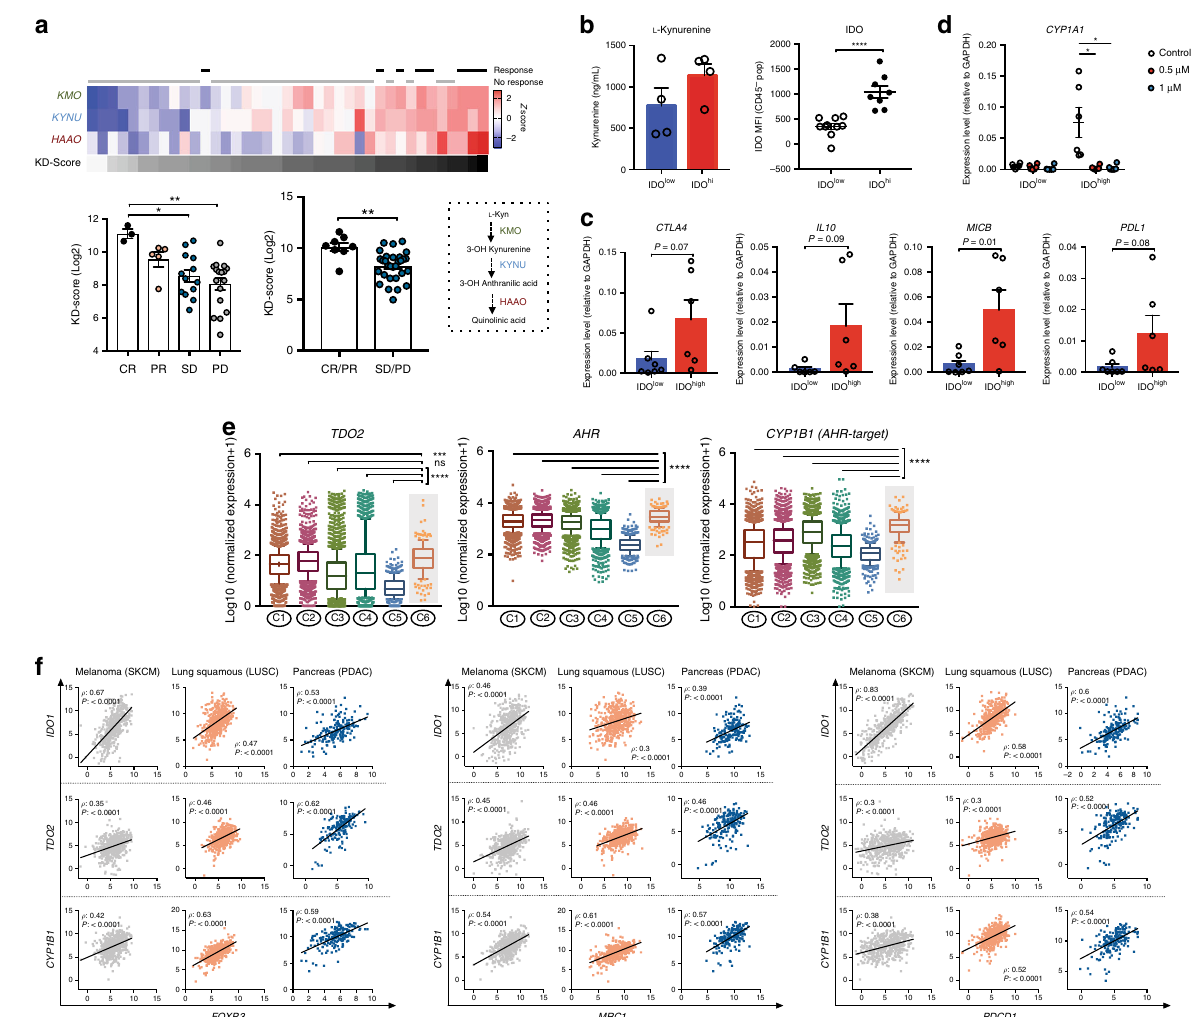
Fig. 1 An active IDO/TDO-Kyn-AHR pathway associates with immune suppressive features in human cancers. a Top: heat-map representing the gene- expression analysis of Kyn-degrading enzymes ( KMO, KYNY, HAAO ) and KD-Score (grayscale) in responsive (complete response/CR or partial response/ PR) highlighted in black ( n = 8), or non responsive (stable disease/SD or progressive disease/PD) highlighted in gray ( n = 31), melanoma patients after PD-1 blockade. Bottom: bar graph with quanti fi cation of KD-Score. b ELISA quanti fi cation of L-Kynurenine in blood serum of melanoma patients (left) categorized as IDO high or IDO low ( n = 4 IDO high and n = 4 IDO low ) based on intracellular IDO staining by FACS of melanoma cell suspensions (right) ( n = 8 IDO high and n = 10 IDO low ). c mRNA of immunoregulatory markers by qRT-PCR analysis in IDO high and IDO low melanoma cell suspensions. d mRNA of AHR-target genes CYP1A1 and CYP1B1 by qRT-PCR analysis in IDO high and IDO low melanoma cell suspensions after treatment with selective AHR inhibitor KYN-101 for 24 h ( n = 6 IDO high and n = 6 – 7 IDO low ). e Distribution of log-transformed expression levels of AHR-related genes ( TDO2, AHR, and CYP1B1 ) across six immune subtypes of cancer (C1: wound-healing, C2: IFN- γ dominant, C3: in fl ammatory, C4: lymphocyte-depleted, C5: immunologically quiet, C6: TGF- β dominant). Data plotted as box and whiskers with the median and limits within the 10 – 90% percentile. f Correlation analysis between Treg marker ( FOXP3 ), myeloid-cell marker ( MRC1/CD206 ), inhibitory checkpoint ( PDCD1/PD-1 ), and AHR-related genes IDO1, TDO2 , and CYP1B1 in TCGA RNAseq data of skin melanoma (SKCM), squamous lung (LUSC) and pancreatic adenocarcinoma (PDAC) analyzed by Spearman rank correlation. Data shown are represented as mean values ± SEM with two-tailed unpaired Student ’ s t test in ( a – d ), one-way ANOVA test with Tukey correction in ( a ) and Kruskal – Wallis with Dunn correction in ( e ). P value: * P < 0.05, ** P < 0.01, *** P < 0.001, **** P < sorted CD8 + T cells from IDO-overexpressing tumors by fl uor- cytokines, including IFN γ , IL-1 β , RANTES, and TNF ɑ after res- escence activated cell sorting (FACS) and further assessed them in timulation with anti-CD3/CD28 as compared to B16 WT -isolated a 3D collagen- fi brin-based killing assay, as previously described 19 . CD8 + T cells (Fig. 2b). Similar dysfunctional phenotype was Analysis of the killing ability of effector CD8 + T cells revealed a observed in CD8 + T cells of the B16 TDO model (Supplemen- dysfunctional phenotype, with a 30% killing ef fi ciency of B16 IDO - tary Fig. 2e) Taken together, our results support a causal role isolated CD8 + T cells as compared to 54% in B16 WT -isolated for the expression of Trp-catabolic enzymes in driving an adaptive CD8 + T cells ( P = 0.01) and 70% of control in vitro activated tumor antigen-speci fi c CD8 + T cells (pmel1.1), which recognize the melanosomal tumor antigen gp100 (pmel1.1) ( P = 0.009) (Fig. 2a). In addition, supernatants from CD8 + T cells isolated from B16 IDO tumors contained lower levels of effector T cell